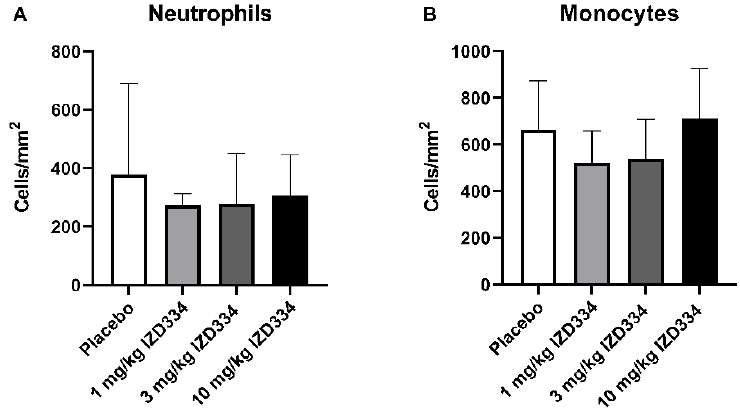
Figure A3. Neutrophil ( A ) and monocyte ( B ) infiltration ( n = 6 – 7).